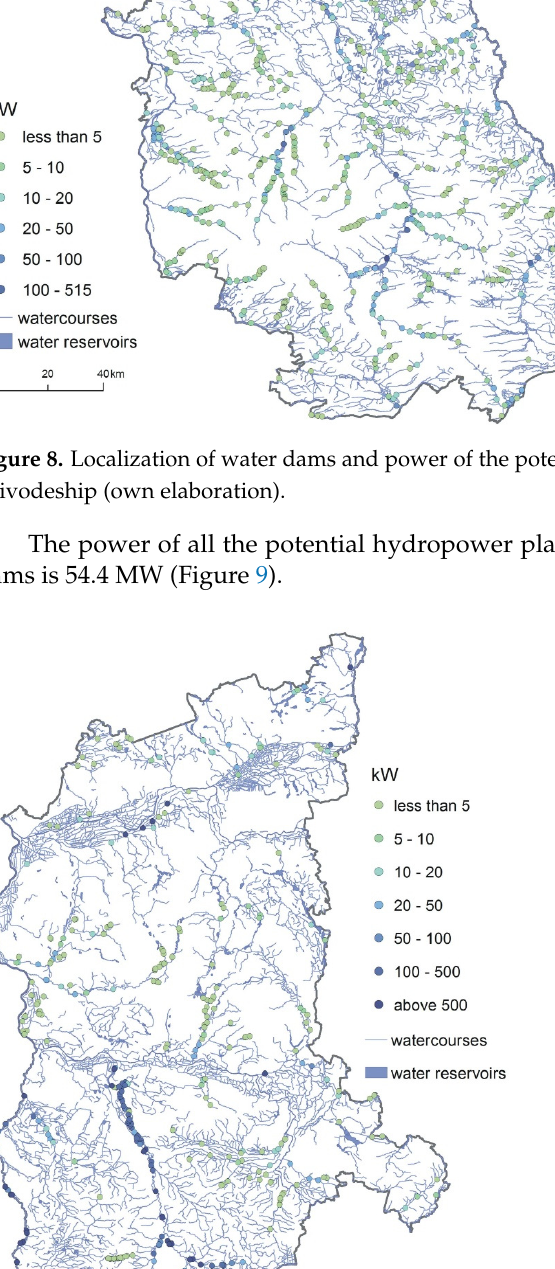
Figure 9. Localization of water dams and power of the potential hydropower plants in the Lubuskie voivodeship (own elaboration). The power of all the potential hydropower plants in the Ł ódzkie voivodeship on dams is 21.1 MW (Figure 10).